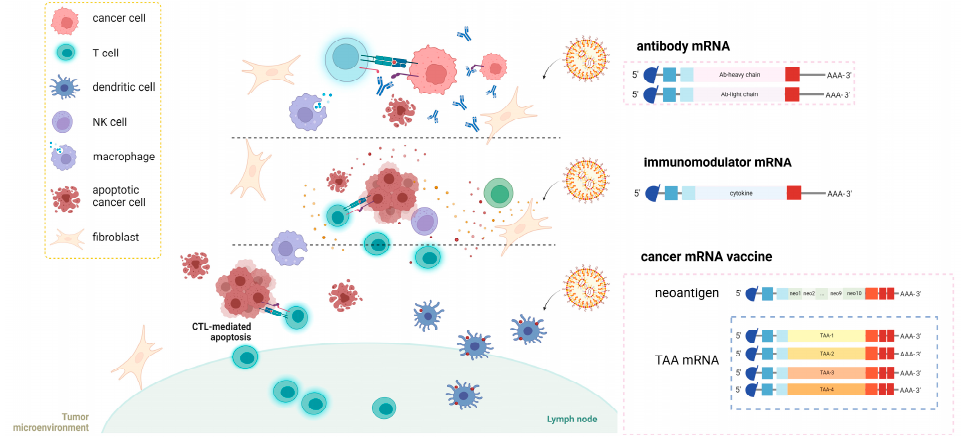
Figure 6. Overview of mRNA-based cancer immunotherapies.